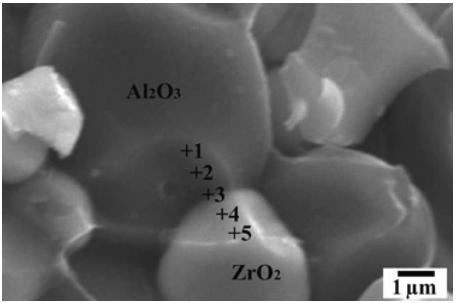
Figure 7 SEM photograph showing bonding between zirconia and corundum (the sample Z